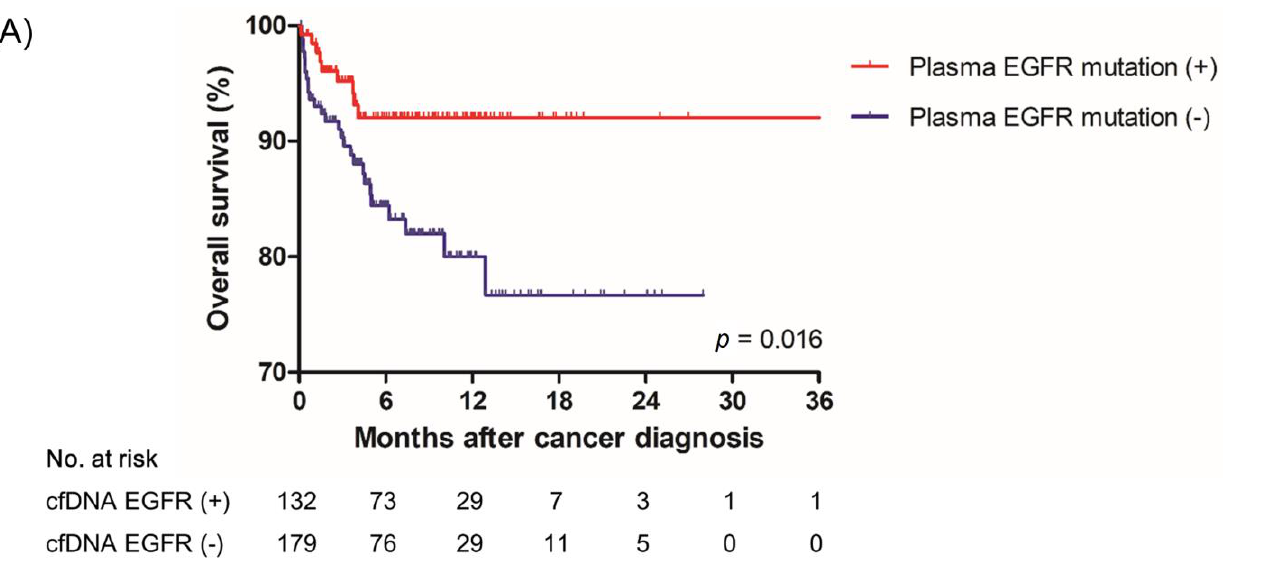
Figure 3. Survival plots of subjects with stage IV NSCLC according to ( A ) plasma and ( B ) tissue EGFR mutation status. 4. Discussion In this cohort of treatment-naïve NSCLC, 20.7% had a positive EGFR result in plasma only, and the treatment decision was based solely on the plasma assay. In multivariable analysis, a higher CEA level, never-smoker status, N3 disease, and presence of brain or intrathoracic metastasis were significantly related to plasma EGFR mutation positivity. The TAT and TTI of the plasma EGFR mutation-positive group were shorter than those of the plasma EGFR mutation-negative group. More patients received the 1st line EGFR-TKI in the plasma positive group compared with the tissue positive group. To the best of our knowledge, this study was the first to report an association between serum CEA levels and a positive plasma EGFR mutation test result. Clinical application of liquid biopsy using plasma cfDNA has increased rapidly for various solid tumors such as lung cancer, breast cancer, colon cancer, melanoma, stomach, etc. [18,19]. Plasma cfDNA technologies have the potential to identify actionable somatic